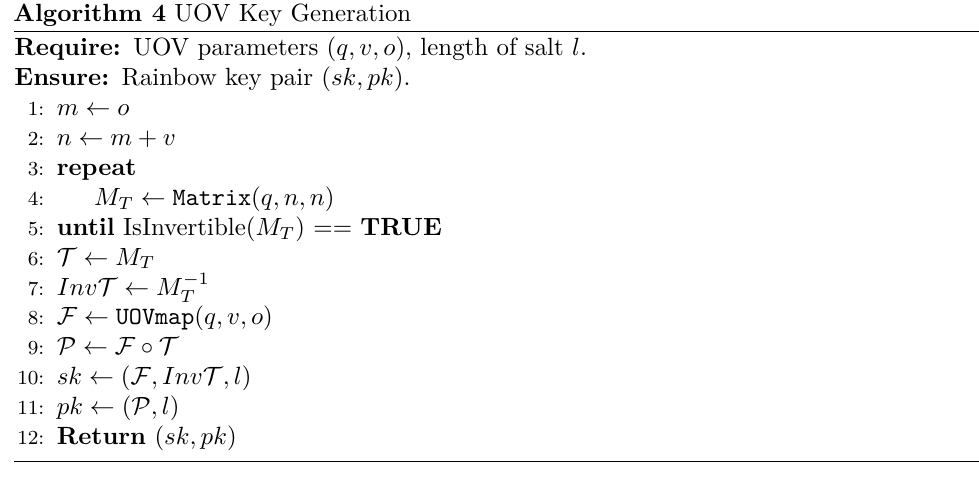
Algorithm 5 UOV Signature Generation